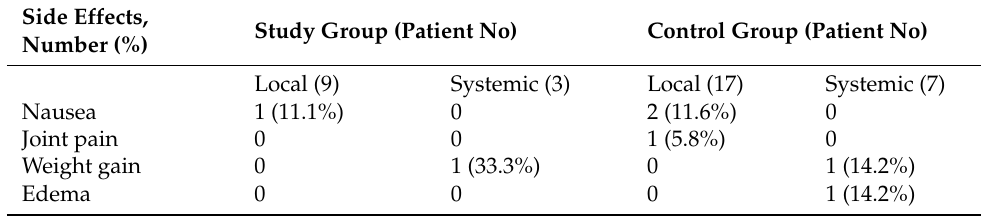
Table 2. Side effects according to